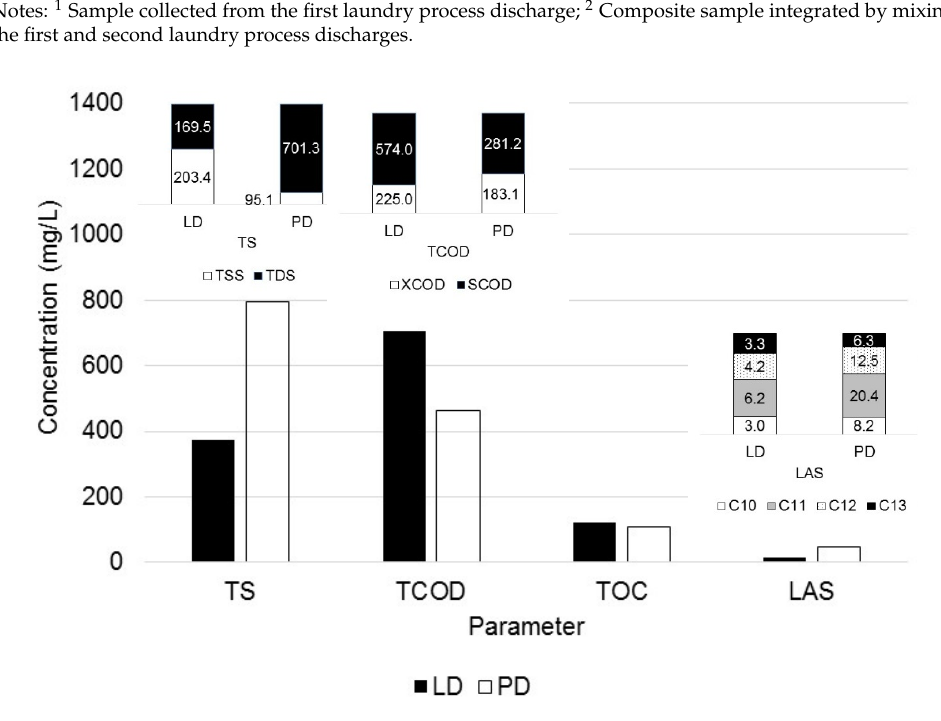
Figure 2. Composition of laundry graywater for LD and PD.